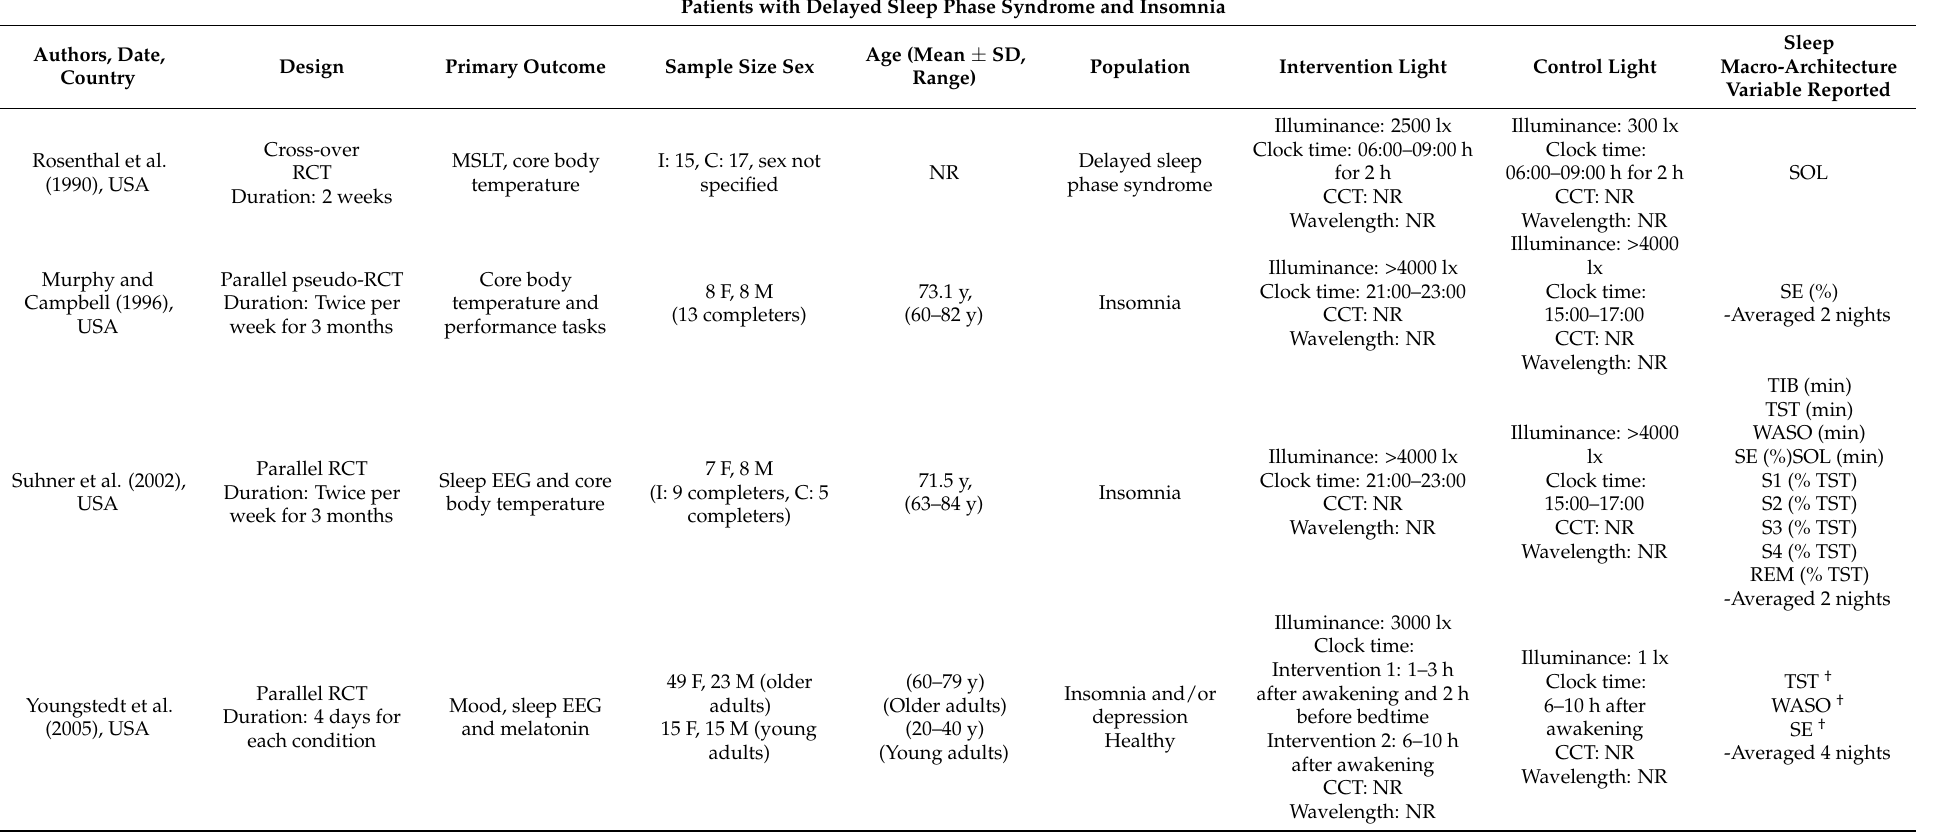
Table 1. Characteristics of randomized studies comparing the effect of light therapy on macro-architecture of sleep